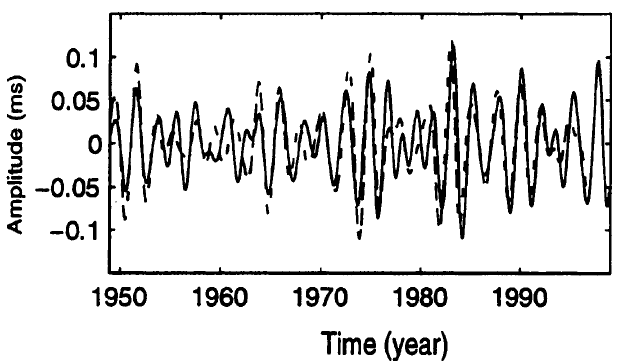
Fig. 11. Interannual variations at the quasi-biennial band (1.5 to 2.9 years) in AAM ( solid line ), MSOI ( dashed ) time series. The AAM time series is given in milliseconds, while the inverted SOI (MSOI) time series is given